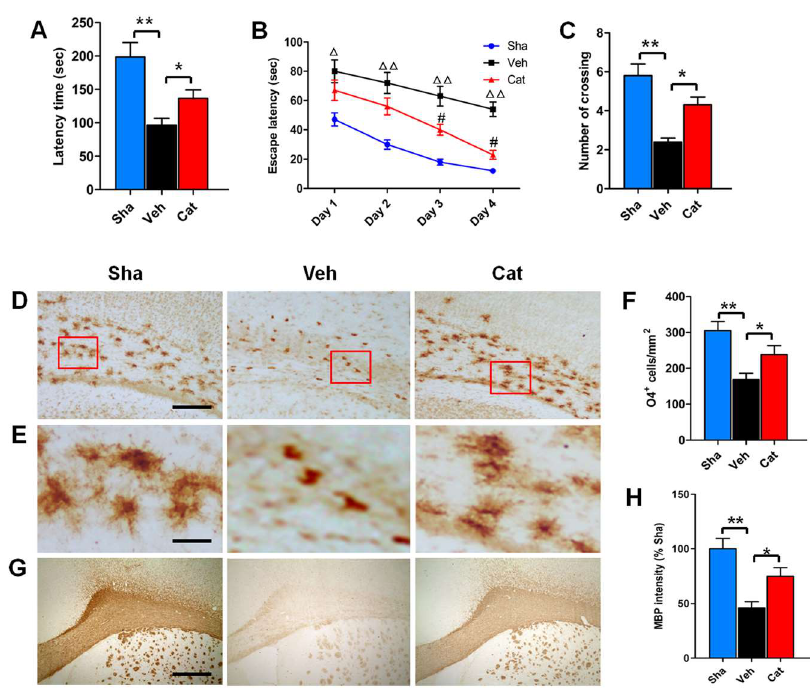
Figure 1. Effects of catalpol on behavioral outcome, premyelinating oligodendrocytes (PreOL) damage, and myelination in a rat model of neonatal hypoxia–ischemia. ( A ) Rotarod test of the latency time for remaining on the cylinder in the sham-control (Sha), vehicle-treated (Veh), and catalpol-treated (Cat) groups. ( B ) Morris water maze test of the escape latency to find the platform in the Sha, Veh, and Cat groups. ( C ) Number of crossings of the previous platform location in the Morris water maze test in the Sha, Veh, and Cat groups. ( D ) Representative O4 staining in the corpus callosum of the Sha, Veh, and Cat groups. Bar = 100 μm. ( E ) High magnification images of O4 staining in the corpus callosum of the Sha, Veh, and Cat groups. Bar = 25 μm. ( F ) Quantification of O4-positive cells in the corpus callosum of the Sha, Veh, and Cat groups. ( G ) Representative myelin basic protein (MBP) staining in the corpus callosum of the Sha, Veh, and Cat groups. Bar = 500 μm. ( H ) Quantification of the optical density of MBP staining in the corpus callosum of the Sha, Veh, and Cat groups. Data are shown as means ± SEM ( n = 6 in each group). * p < 0.05, ** p < 0.01 vs. indicated group; △ p < 0.05, △△ p < 0.01 vs. Sha; # p < 0.05 vs. Veh.